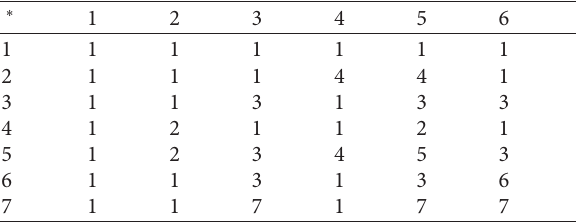
Table 2: Table of Example 2.